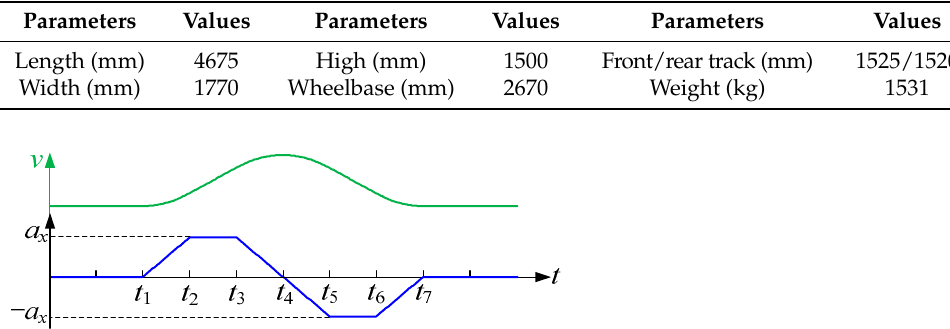
Figure 11. Displacement responses of node 14 under different non-inertial conditions: ( a ) x -direc- tion; ( b ) y -direction.